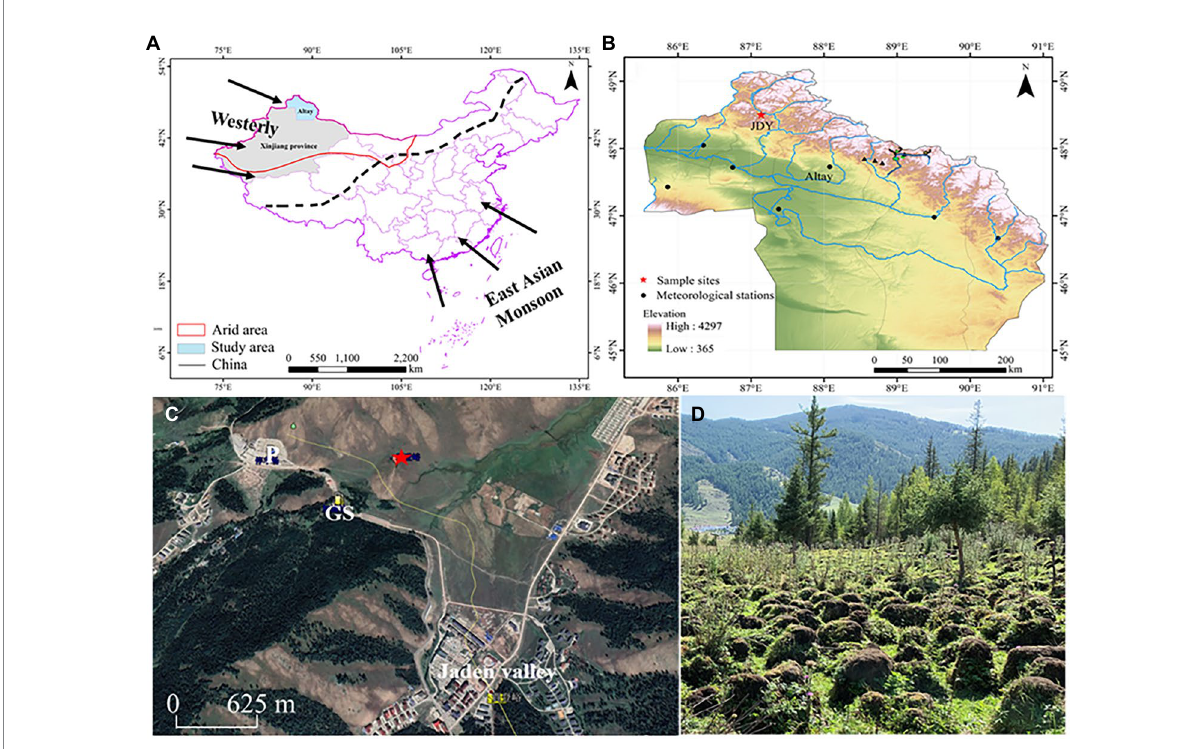
FIGURE 1 (A) China map showing the location of Jiadengyu in Northwest China and the Asian Monsoon and the Westerly; (B) Satellite image of the Jiadengyu valley (Google Earth) showing the location of JDY peatland (Red five pointed star) and of a car park and gas station; (C) Geographical map showing the sampling site in Altay Mountains, northwest China; and (D) Photo showing the summer scene in the studied peatland (photo in August 2019). Please refer to the Online version for the color